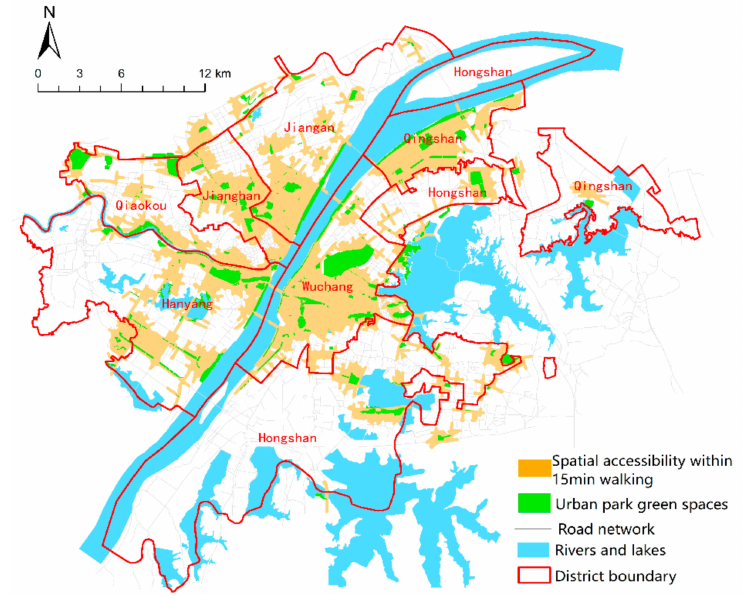
Figure 7. Service areas for urban park green space according to the network analysis